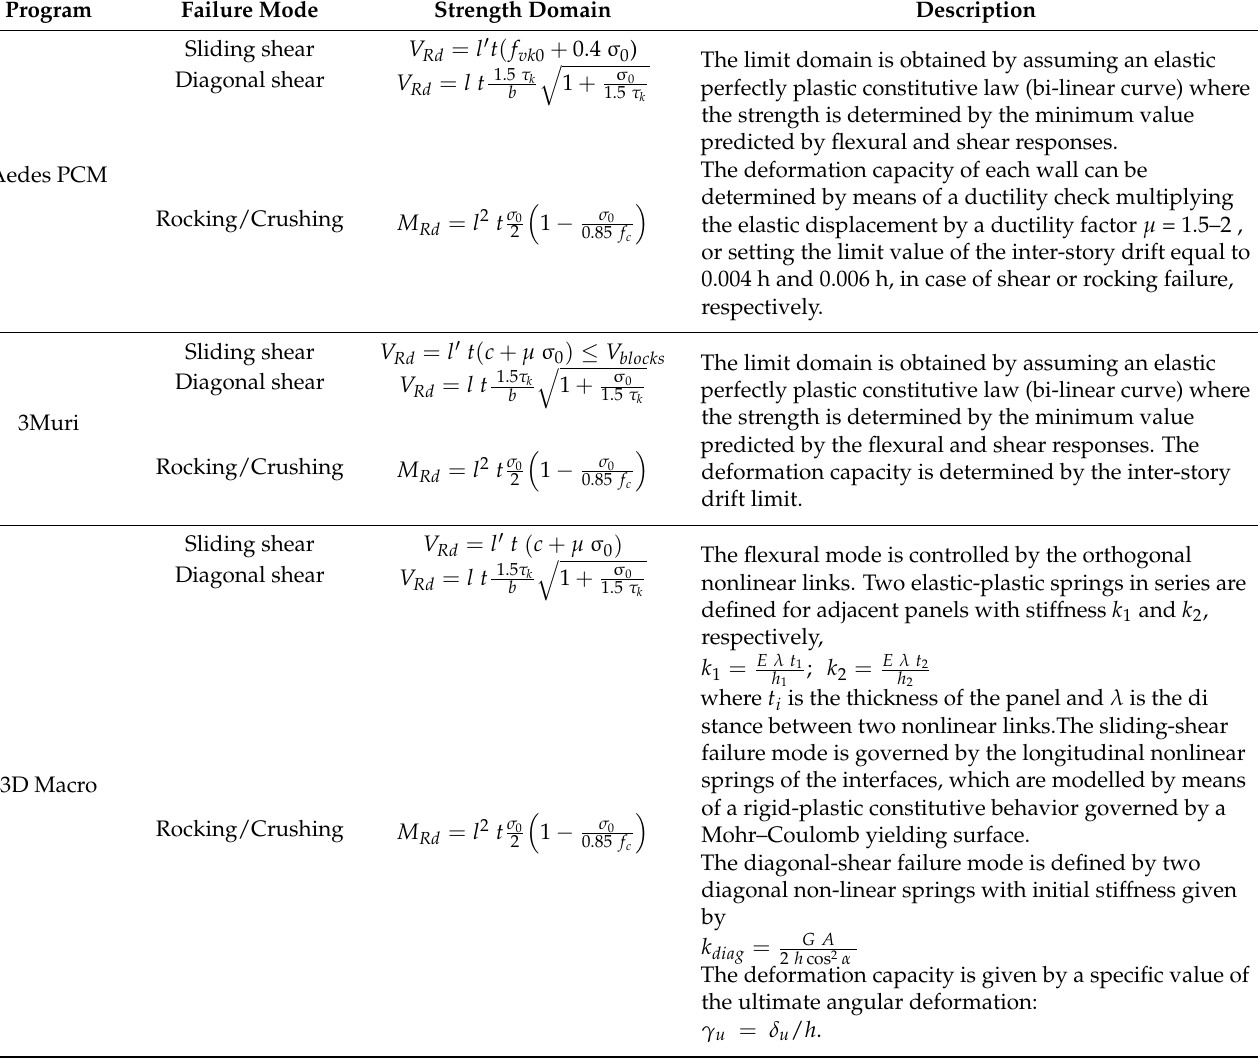
Table 1. Strength criteria for masonry walls implemented in the macro-element programs, Aedes PCM, 3MURI and 3DMacro. In the formulas, l is the length of the wall, t is the thickness, l (cid:48) is the length of the compressed part of the wall, τ k is the shear strength, f vk 0 is the sliding shear strength, c is the cohesion coefficient, µ is the friction coefficient, f c is the compressive strength, σ 0 is the compressive stress on the wall and b is the stress distribution